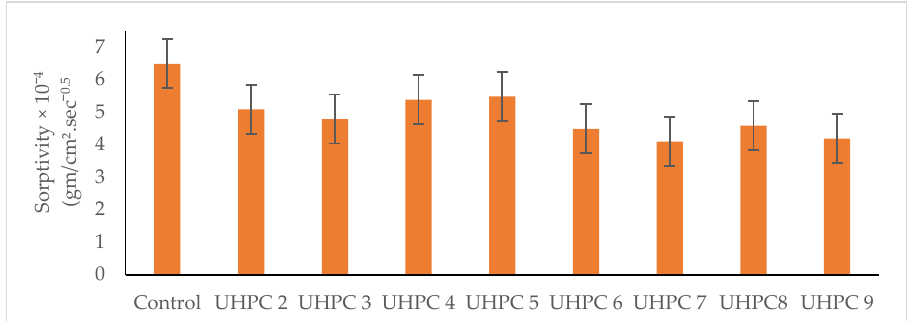
Figure 10. Sorptivity for glass and lime powder replacement ratios at 90 days.